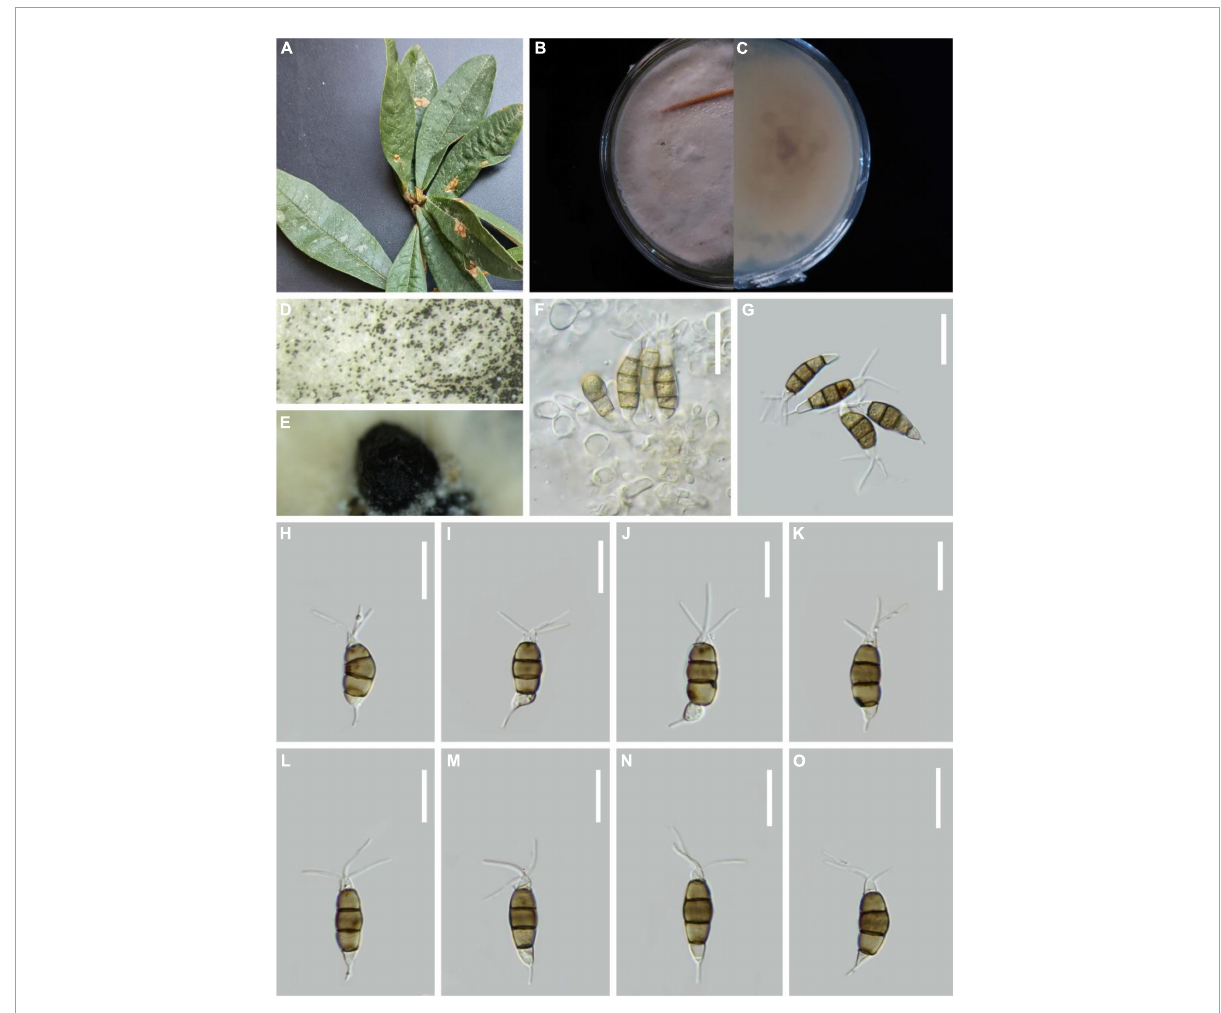
FIGURE3 Pestalotiopsis cangshanensis (KUN-HKAS 124573, holotype). (A) Leaves of Rhododendron delavayi . (B,C) Culture on potato dextrose agar (PDA) (upper and lower view). (D,E) Conidiomata on PDA. (F) Conidiophores, conidiogenous cells, and conidia. (G–O) Conidia with appendages. Scale